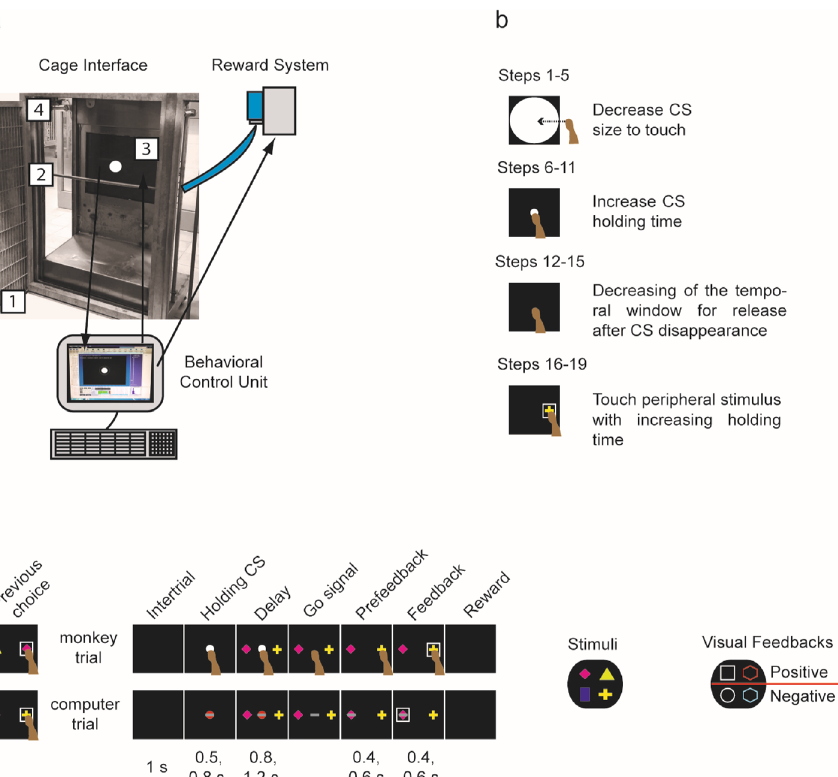
Figure 1. Schematic illustration of the home-cage training system and tasks. ( a ) Home-cage training system. The photograph on the left shows the cage interface (CI) connected through the guillotine door to the experimental cage. The monkey sits in front of the opening of the CI (1) where a stainless steel tube (2) releases the reward via a reward system (top right image). A touchscreen (3) allows the monkey to perform the task. A wide-angle camera (4) monitors the monkey during sessions. The lower image shows the behavioral control unit, which is connected to the touchscreen, reward system, and camera and is used to run the tasks and record the monkey’s responses. ( b ) The 19 steps presented during phase 1 of experiment 1. The monkey learns to touch a central stimulus (CS) of progressively smaller size (steps 1–5); to keep touching the CS while it is on the screen (steps 6–11); to remove its hand after the CS is turned off within a specific time window (steps 12–15), and to touch and continue toughing a target when it is presented on the screen (steps 16–19). ( c ) The sequence of events of one trial of the non-match-to-goal task. The upper section shows a trial performed by the monkeys in phase 2 of experiment 1 and in experiment 2. The lower section shows a trial performed by the ghost agent in experiment 2. The black rectangle represents the touchscreen. The white or red circle is the CS, and the disappearance of the CS represents the go signal for starting the movement. The targets (here, a pink rhombus and a yellow cross) are the stimuli for the choice. The gray rectangle in the computer trial simulates the sequence of actions necessary to carry out a correct complete trial. The first black rectangle on the left shows the target chosen in the previous trial that was, according to the task design, presented again in the current trial, alongside a different stimulus. On the right the four targets and the four types of visual feedback for both experiments are shown. Under the two example trials, the duration of each is